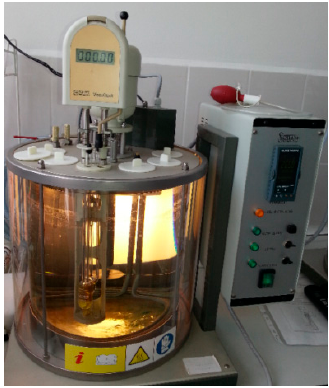
Figure 4. Kinematic viscosity determination equipment.